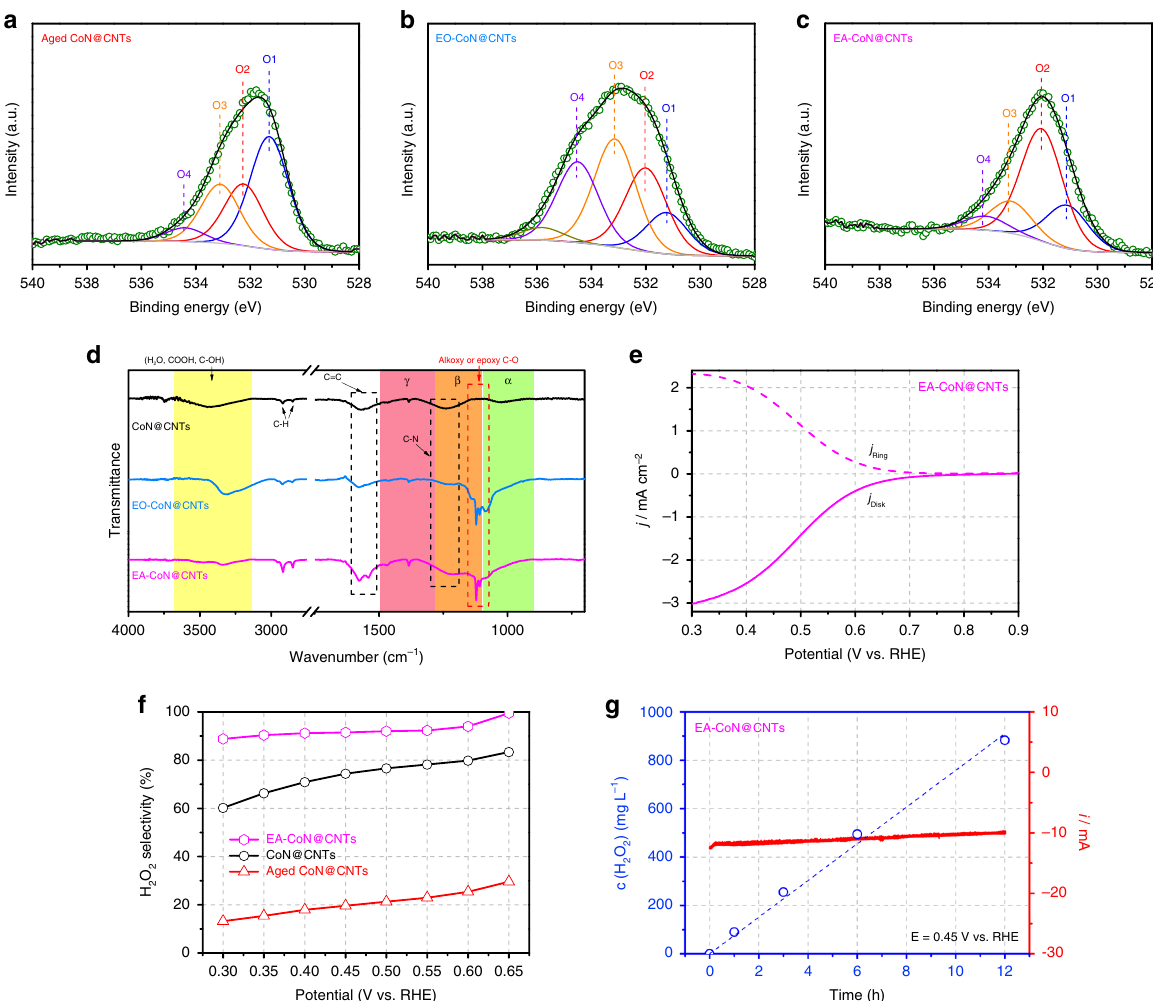
Fig. 3 Electrochemical activation (EA) of CoN@CNTs. XPS O 1s spectra of a aged CoN@CNTs, b EO-CoN@CNTs and c EA-CoN@CNTs. d Background- corrected FTIR spectra of CoN@CNTs before and after ETs. e RRDE voltammograms of CoN@CNTs after EA (including EO and then ER) at 1600 rpm in an O 2 -saturated 0.1 M HClO 4 electrolyte with disc current and ring current. f Calculated H 2 O 2 selectivity on CoN@CNTs, aged CoN@CNTs and EA- CoN@CNTs based on the RRDE measurements. g H 2 O 2 production amount (determined via the potassium permanganate titration) as a function of time on the EA-CoN@CNTs. Current (red curve) and concentration (blue ○ ) behavior with time for the electrochemical H 2 O 2 production is